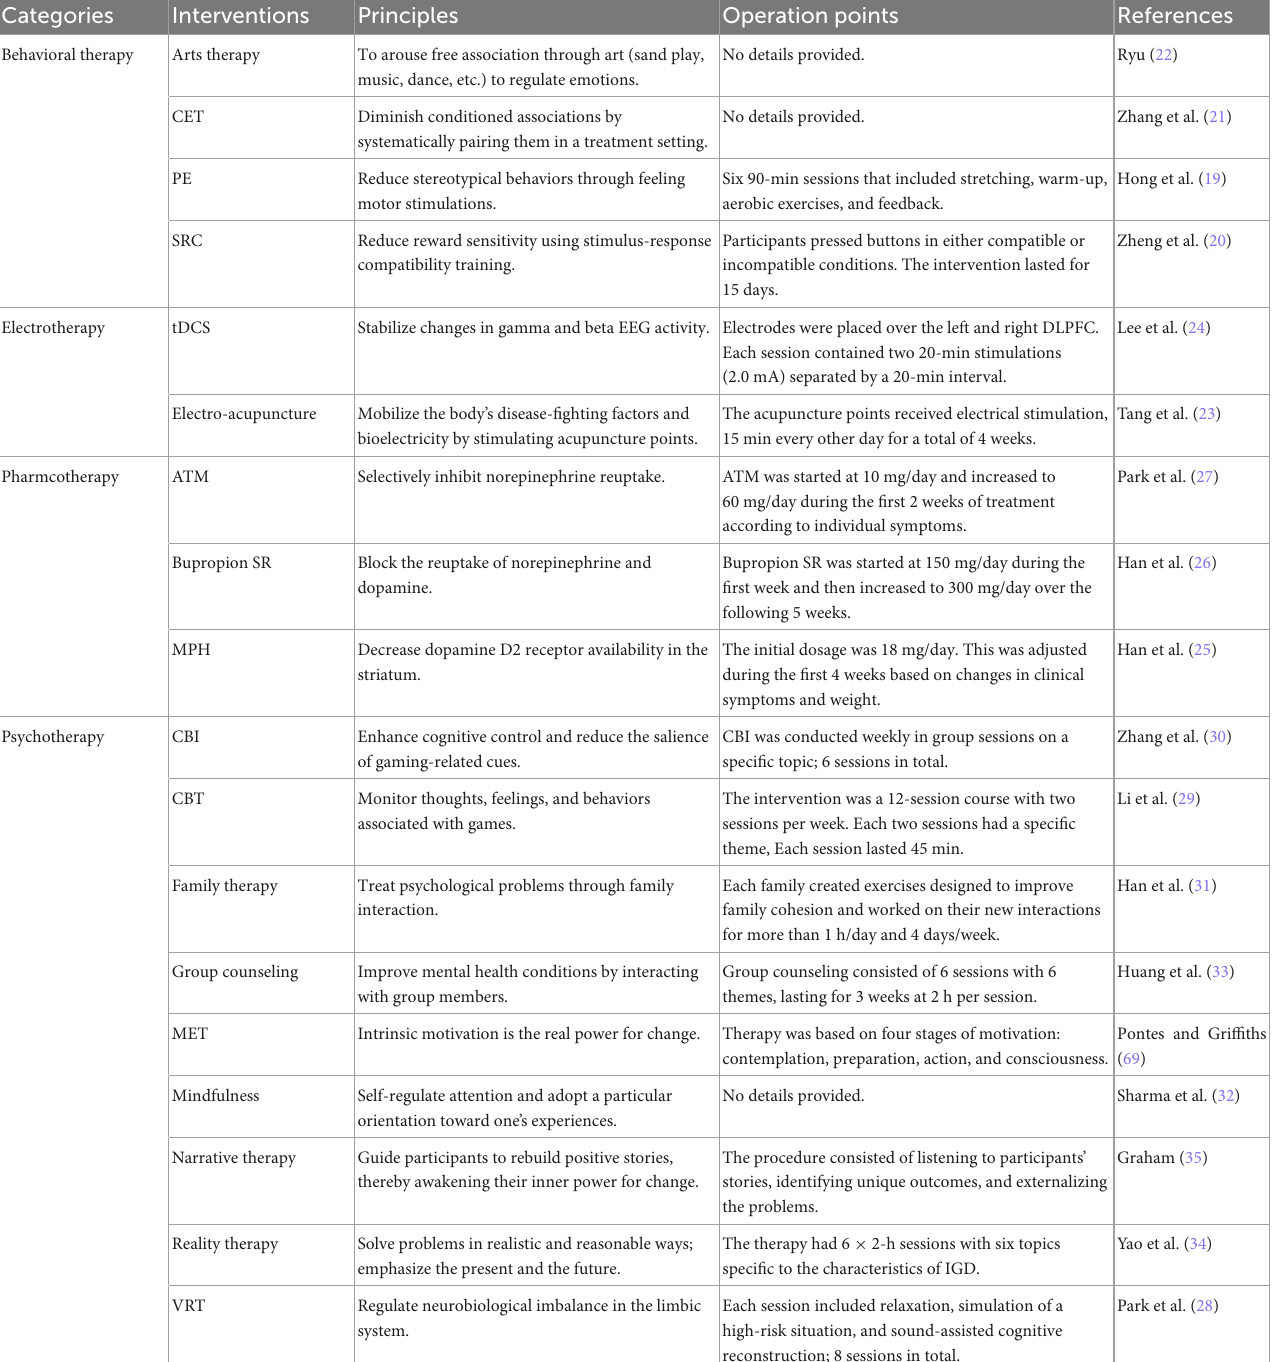
TABLE 1 Characteristics of gaming disorder (GD)